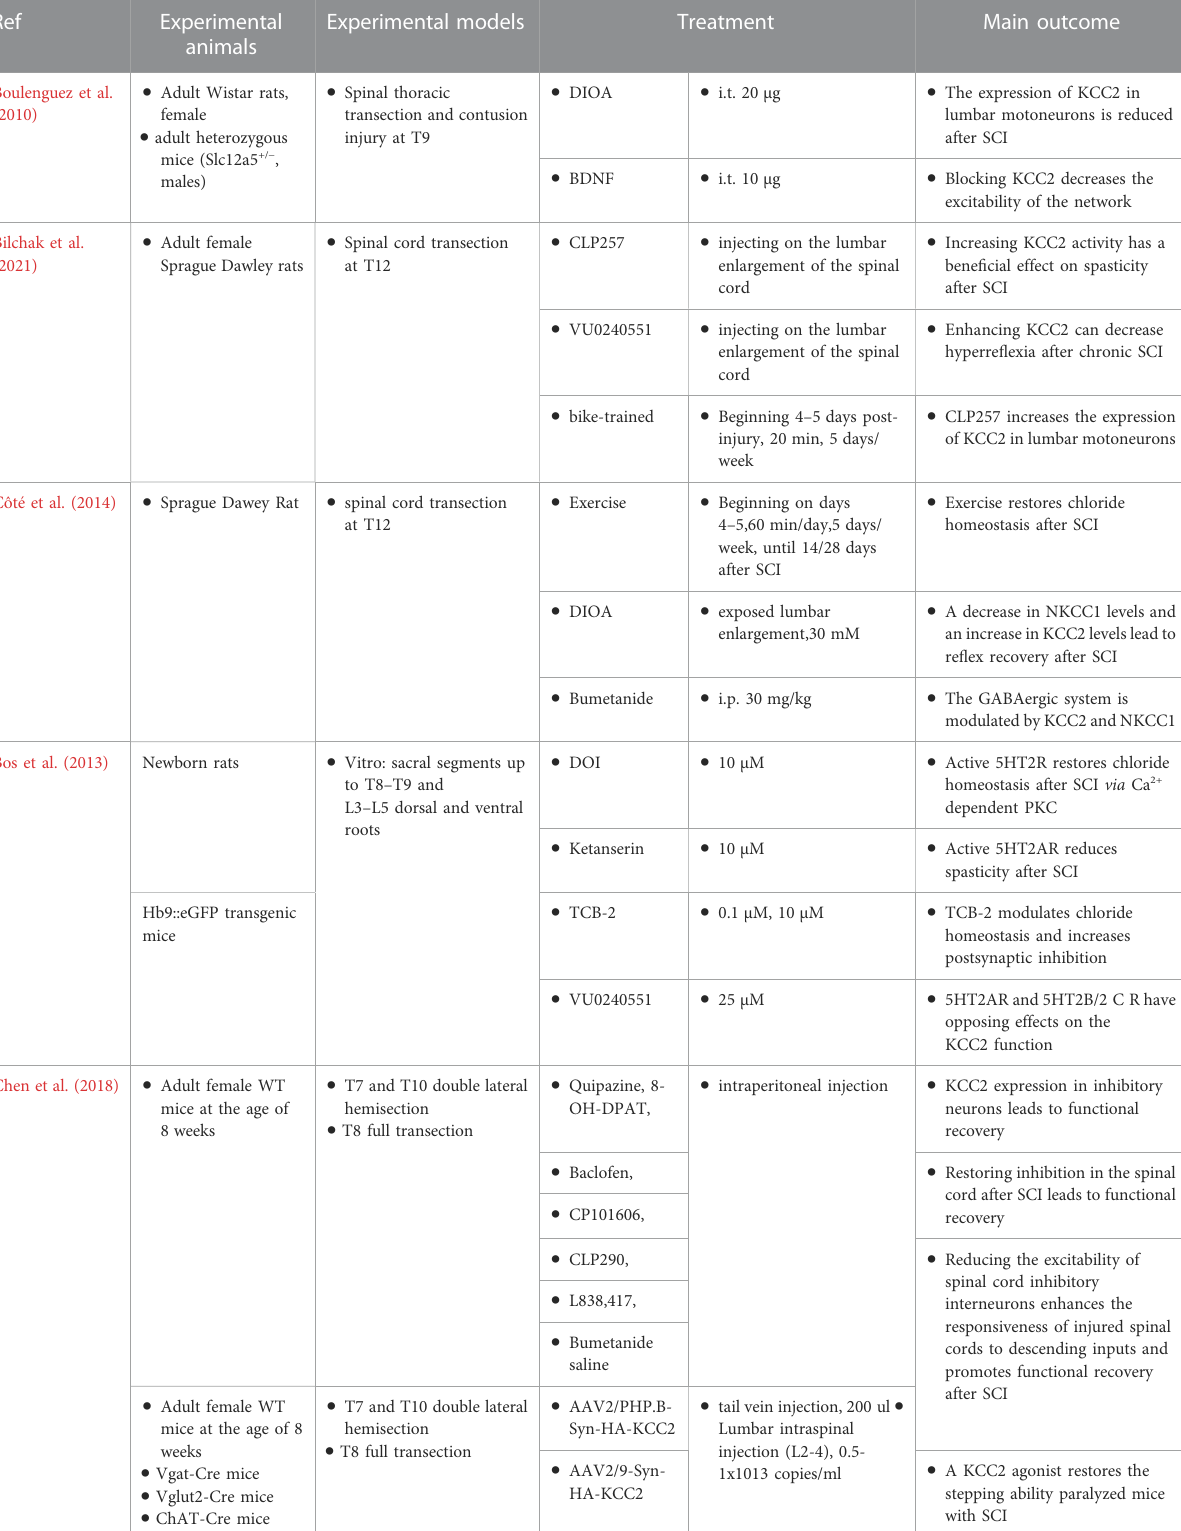
TABLE 1 Summary of animal experiments related to the regulation of KCC2 and NKCC1 after spinal cord